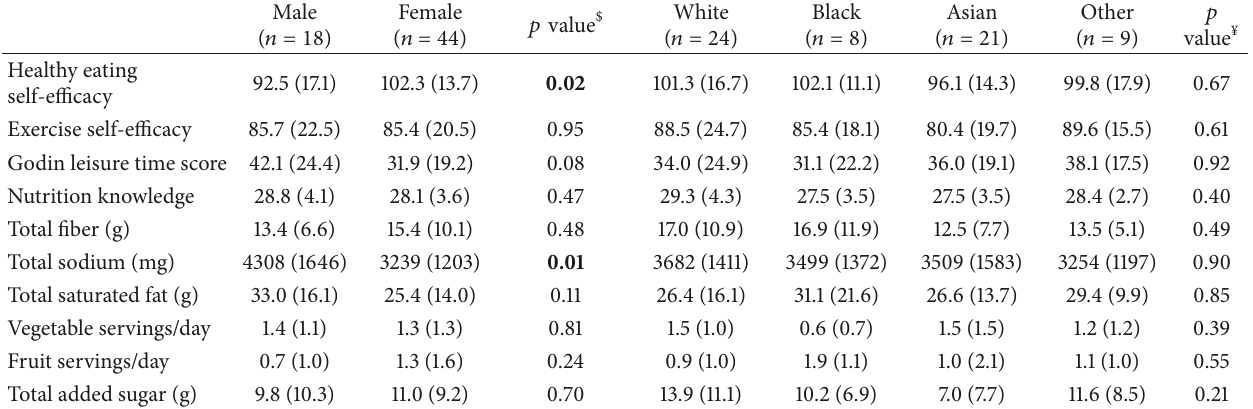
Table 1: Mean (SD) by sex and